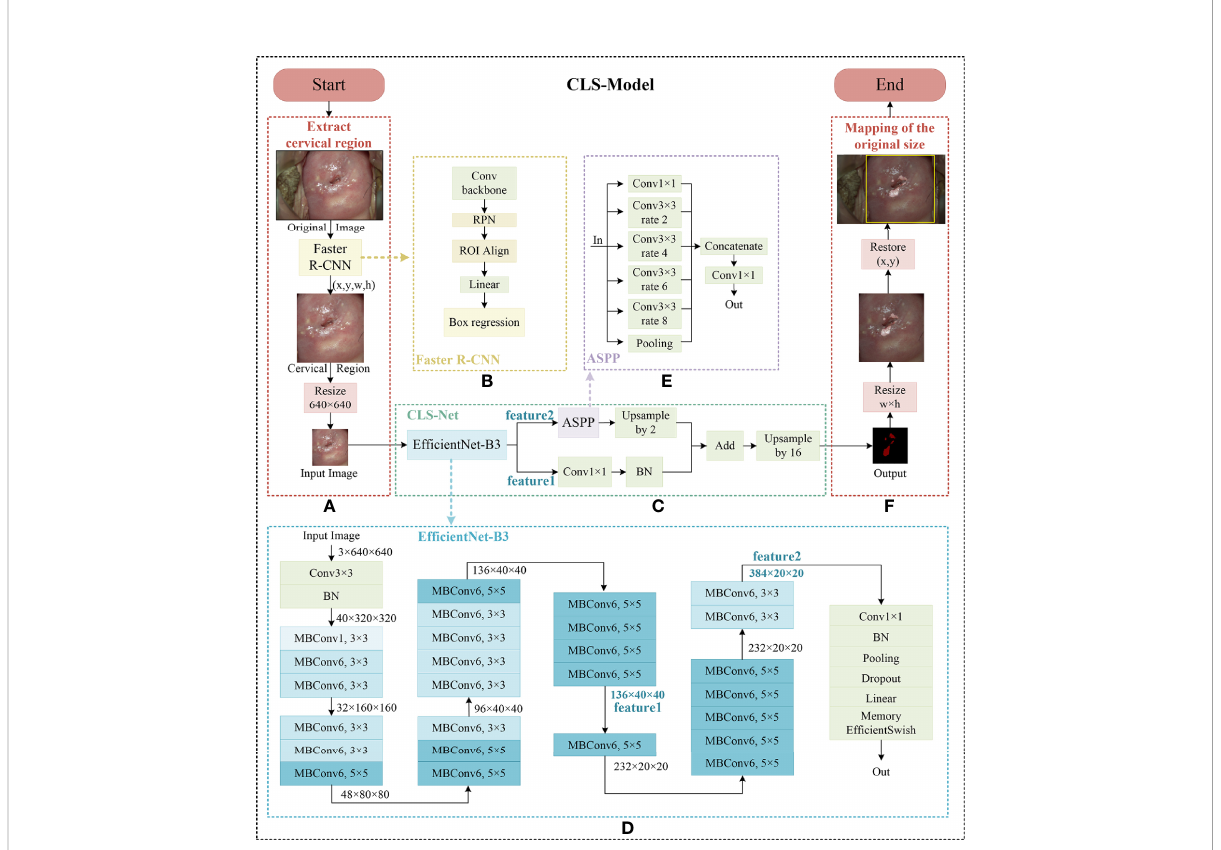
FIGURE 1 The overall architecture of CLS-Model. (A) The architecture of the cervical region extraction model, (B) the improved Faster R-CNN, (C) CLS- Net, (D) Ef fi cientNet-B3, (E) ASPP, and (F) mapping (the yellow box is the cervical region, and the pink-white region is the lesion. Normal region is indicated by a translucent gray